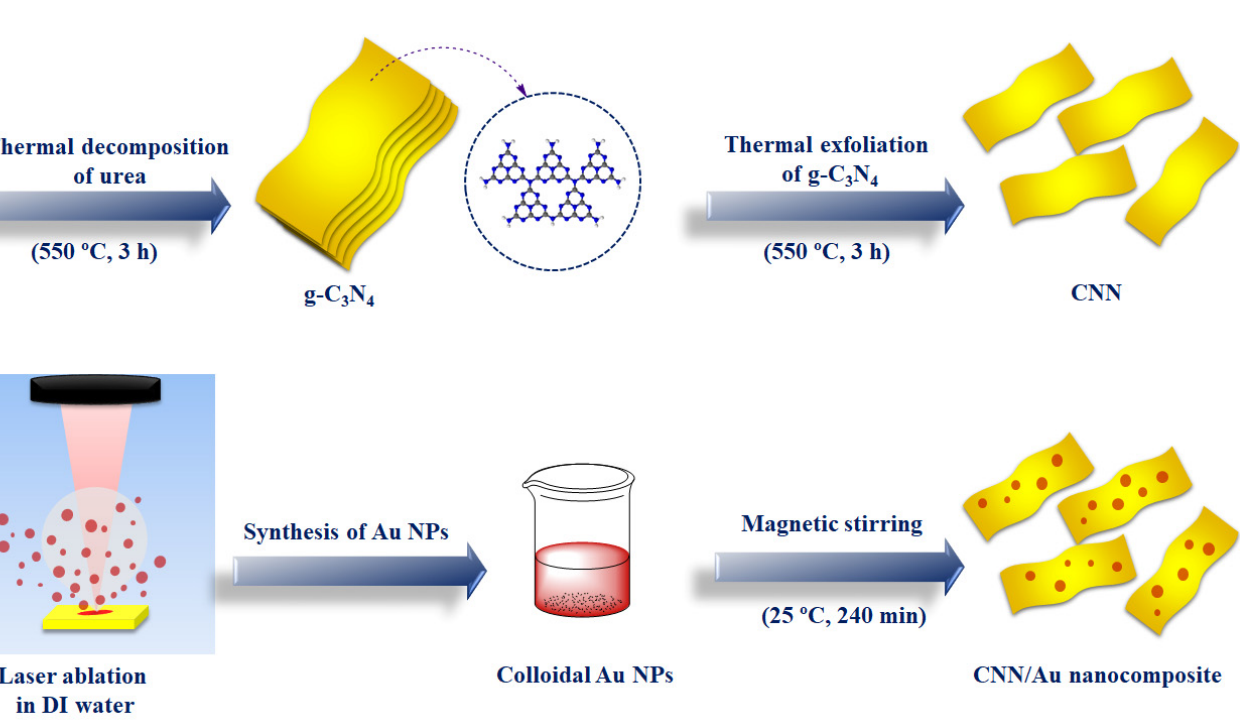
Figure 1. Representation for the synthesis of ( a ) CNN and ( b ) CNN/Au nanocomposite. To synthesize Au NPs, the LAL protocol was deployed by means of nanosecond fiber laser (RFLP30Q, 1064 nm, 30 W). At first, ultrasonic cleaning in acetone and deionized water (DW) media was utilized for the removal of foreign contaminants from surface of a metallic piece of Au (99.9%). It was then submerged in a glass vessel containing 10 mL of DW. The fiber laser with scanning speed of 200 mm/s, pulse length of 100 ns, and frequency of 20 kHz was deployed to irradiate the Au surfaces. To synthesize Au NPs, the beam of laser was fixated on the Au surface, in an area of 20 × 10 mm 2 . The Au NPs’ generation was easily recognized by the human eye when the color of the DW gradually changed to red. Stopping the laser irradiation of the Au target and refreshing the 10 mL of clean DW every 1 min prevented the formation of Au NP aggregates. The laser irradiation time to synthesize the colloidal Au NPs lasted nearly 3 min. NPs were added to it and scattered for 60 min again. After that, the suspension was stirred for 240 min and dried, as depicted in Figure 1b. All the processes were performed under ambient